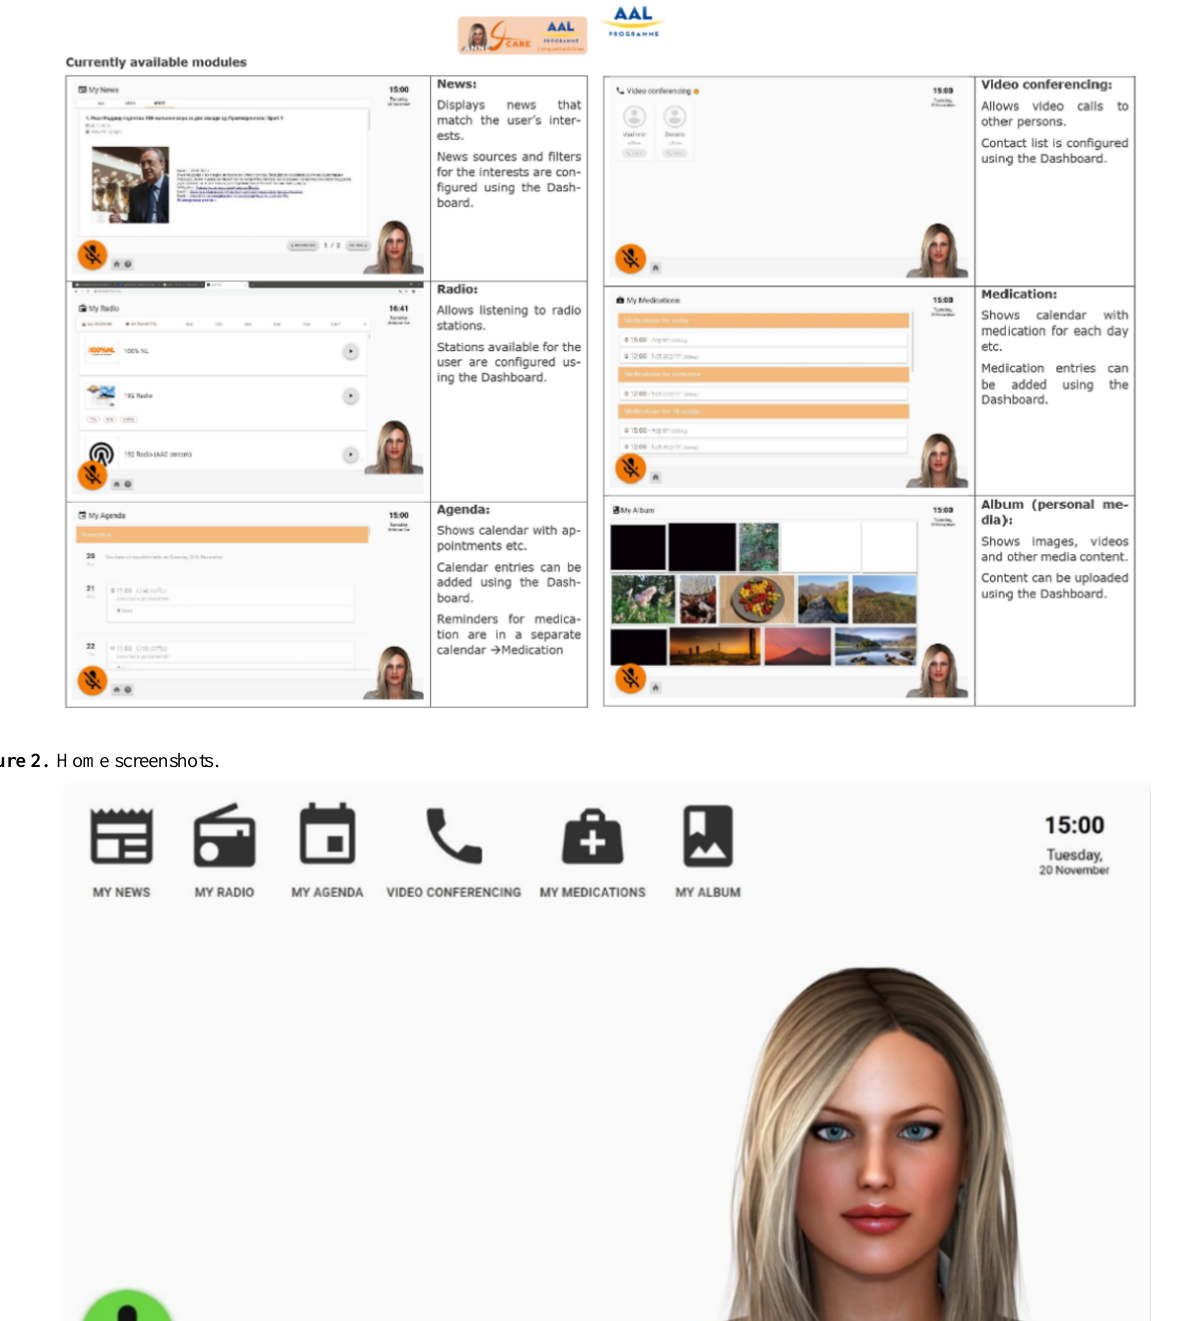
Figure 1. Screenshots of current available modules showing an example layout. The layout can be different, or the module hidden or disabled, depending on user abilities.